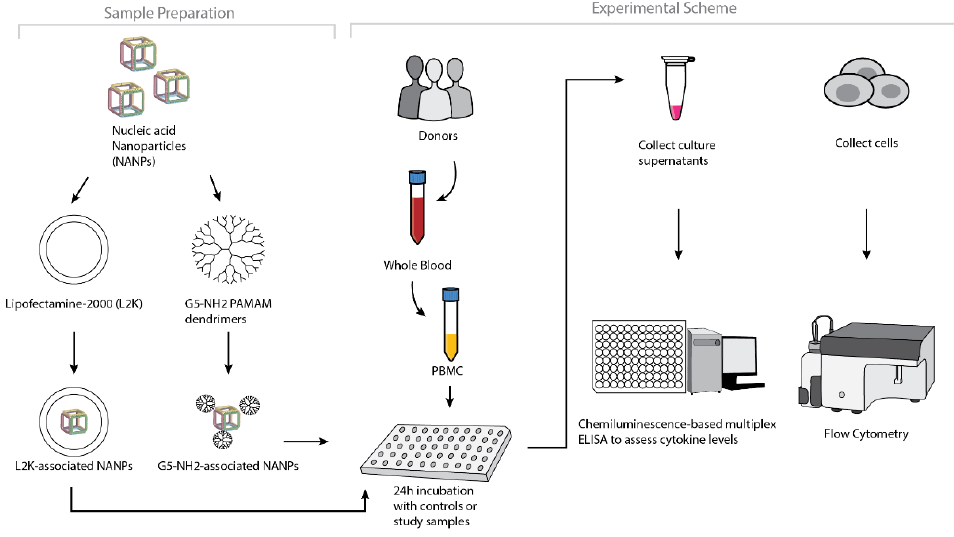
Figure 4. Experimental flow of the complexation of DNA and RNA cubes with either G5-NH 2 dendrimers or L2K and their further analysis in PBMCs.